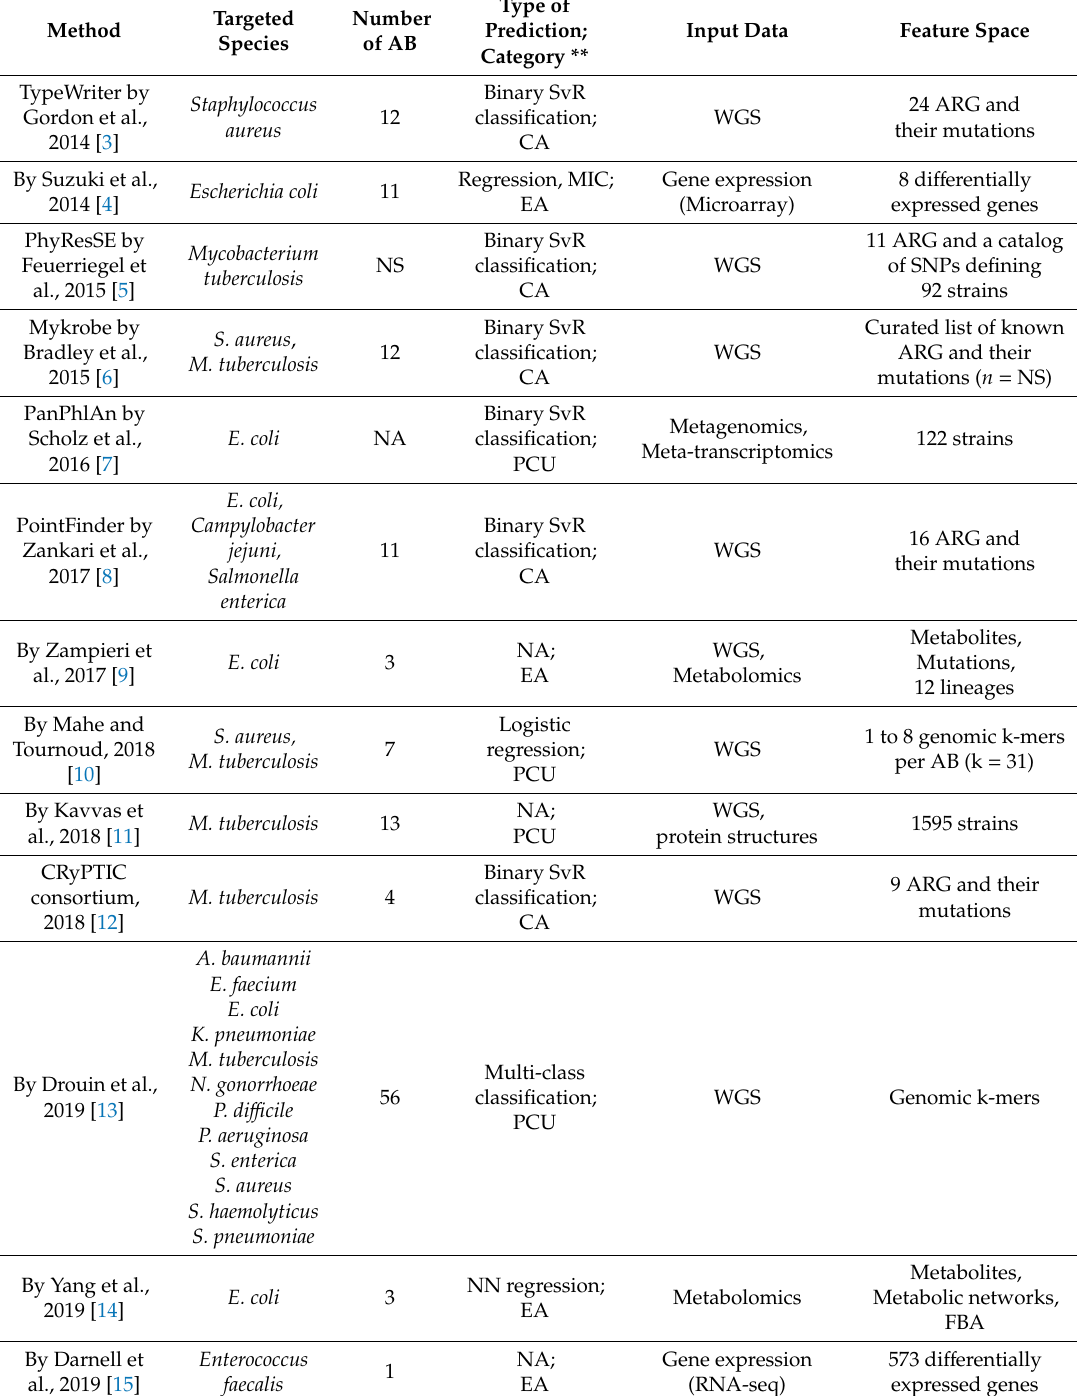
Table 1. Representative bioinformatics methods for AMR analysis and prediction